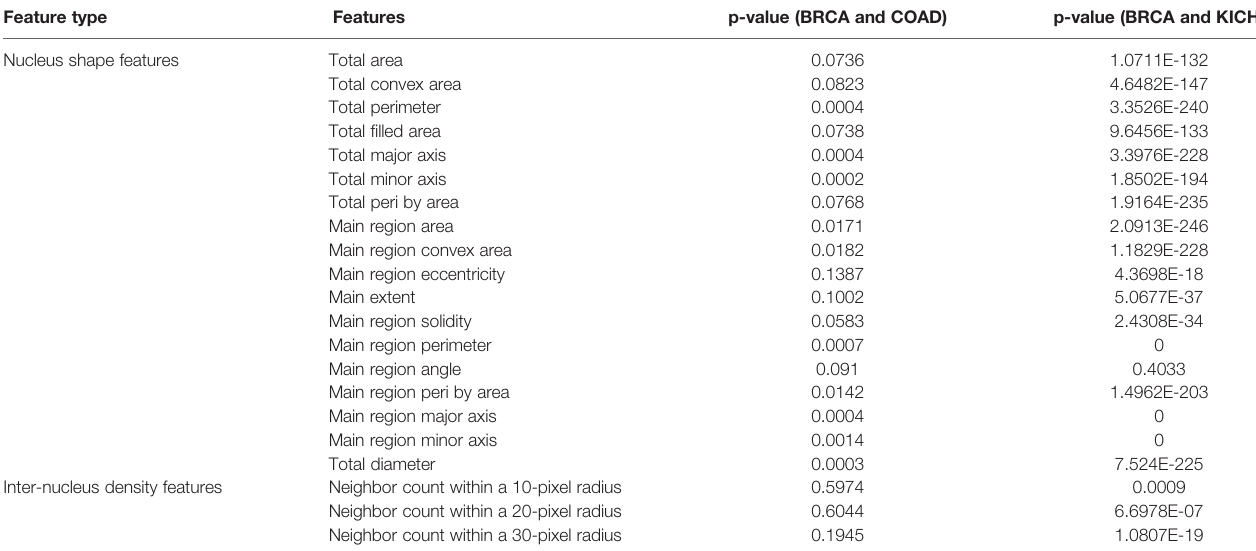
TABLE 2 | Nucleus feature statistical analysis: the table showing the p-values obtained after performing the t-test on two pairs of groups (BRCA-COAD) and (BRCA-KICH). Feature